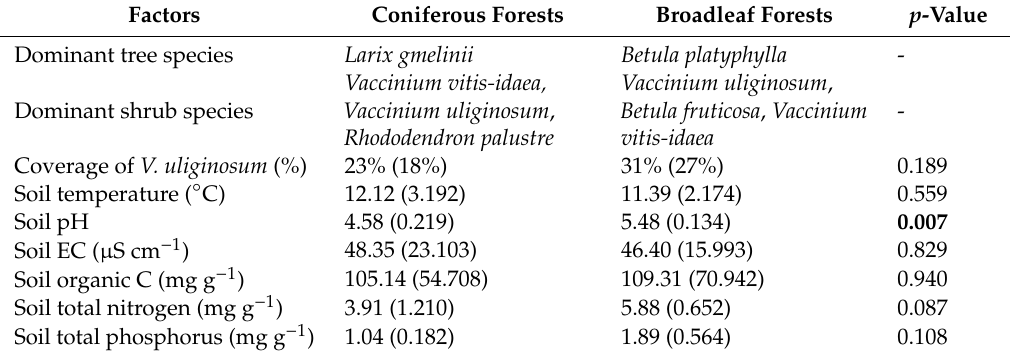
Table 1. Vegetation characteristics and soil properties in coniferous and broadleaf